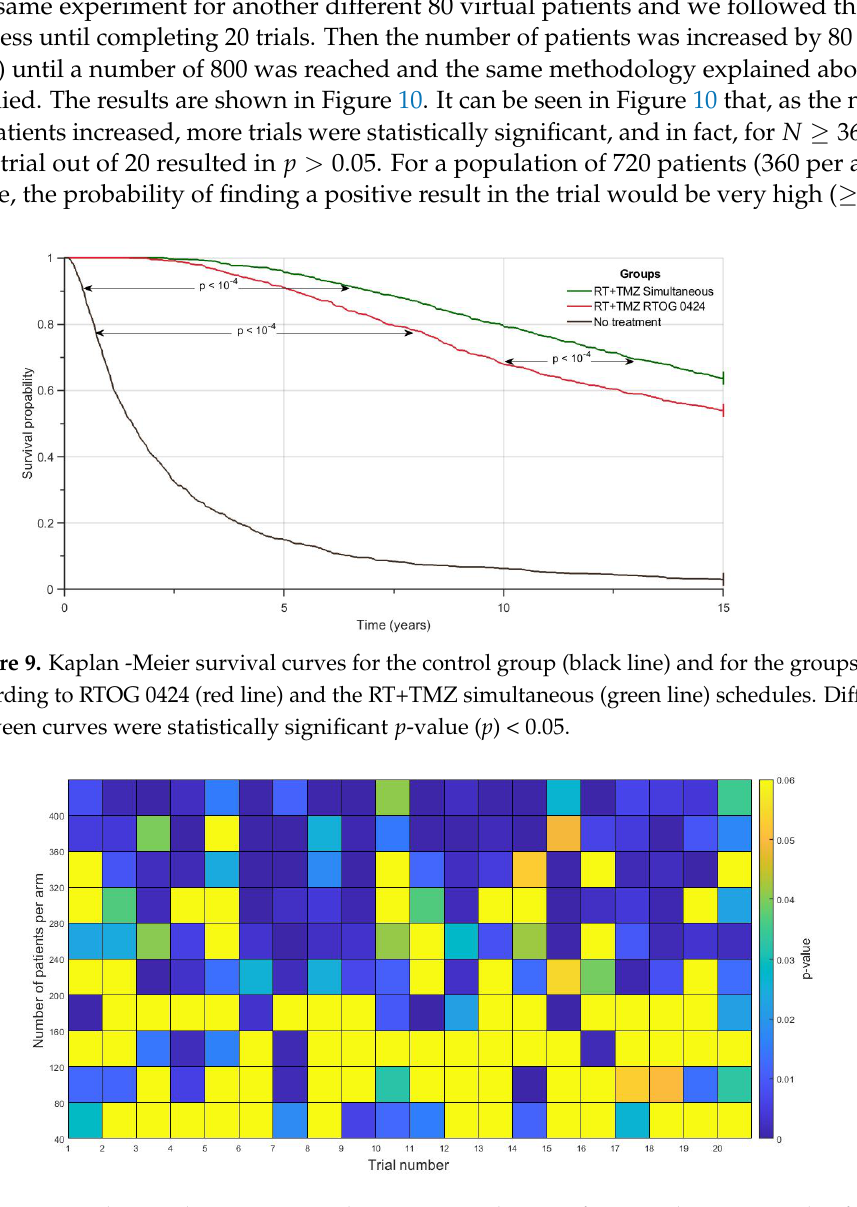
Figure 10. In-silico studies comparing the KM survival curves for virtual patients with a followup period of 15 years treated according to RTOG 0424 vs simultaneous RT+TMZ. The pseudocolor plot shows the p -values for each trial as the number of patients per arm is increased. For a patient population greater than 720 (360 per arm) the probability of finding statistically significant differences between curves is ≥